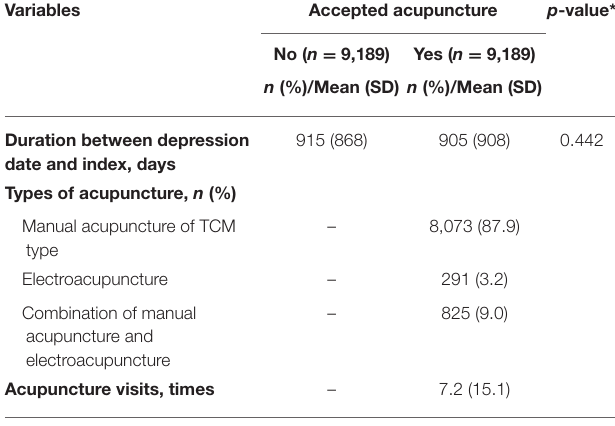
TABLE 1 | Characteristics of patients with depression accepted and non-accepted